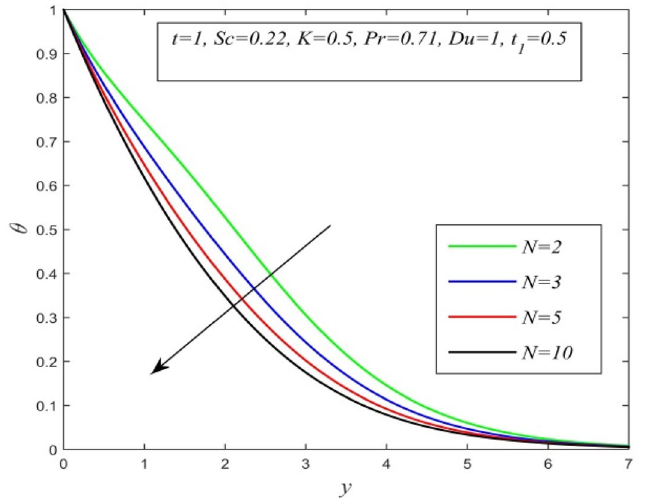
Figure 9. θ versus y for different N and t = 1, Sc = 0.22, K = 0.5, Pr = 0.71, Du = 1, t 1 = 0.5.